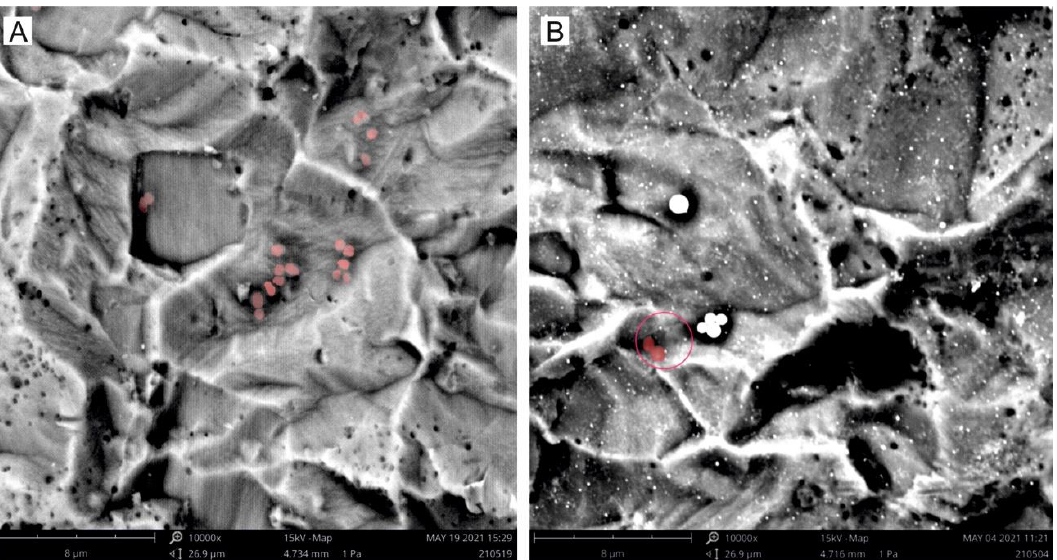
Figure 10. SEM images of bacterial adhesion on ( A ) bare titanium and ( B ) titanium with palladium NPs synthesized by laser ablation in water with 532 nm of wavelength. Bacteria are highlighted in false color red for clarity.